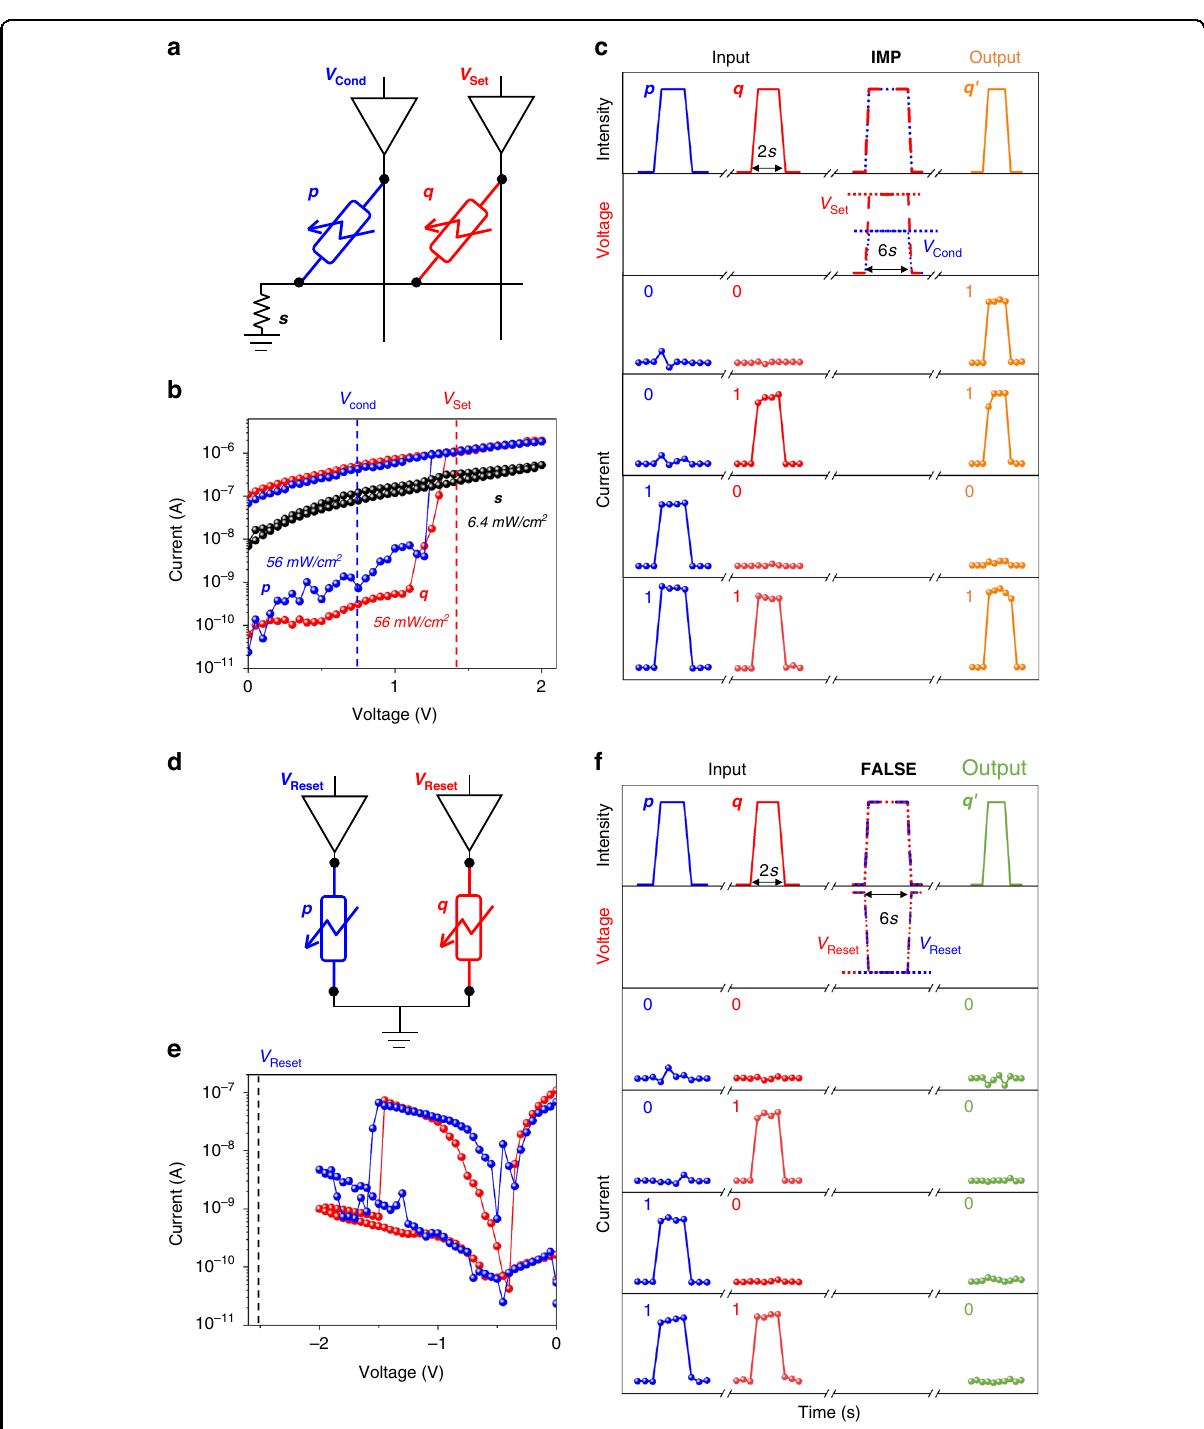
Fig. 3 “ Photoresponse-stateful ” strategy. a Illustration of an in-memory IMP operation based on a set of photomemristors triggered by light stimuli. b I-V characteristics of devices s , p and q under illumination with different light intensities. c Diagram of the optical and electrical pulses applied for the IMP operation. The blue and red curves show the optical and electrical signal of devices p and q before and during the IMP operation, and the orange curves show the change in photoresponse states after IMP operations, reproducing the IMP truth table. d Illustration of an in-memory FALSE operation triggered by light stimuli based on a set of photomemristors. e I-V characteristics of devices p and q under illumination. f Diagram of the optical and electrical pulses applied for the FALSE operation. The blue and red curves show the optical and electrical signal of devices p and q before and during the FALSE operation. The black curves show the change in photoresponse states after FALSE operations, reproducing the FALSE truth